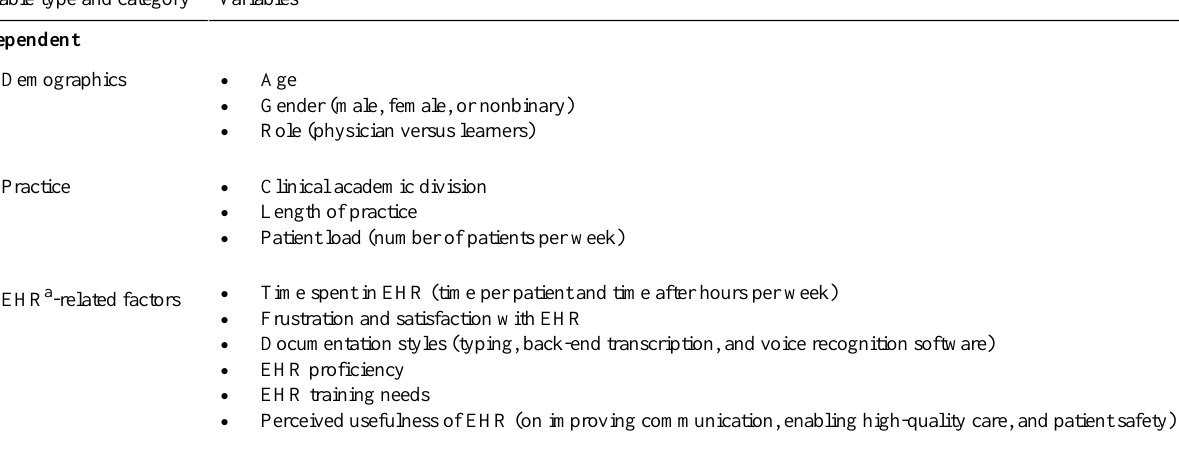
Table 1. Independent and dependent variables. VariablesVariable type and